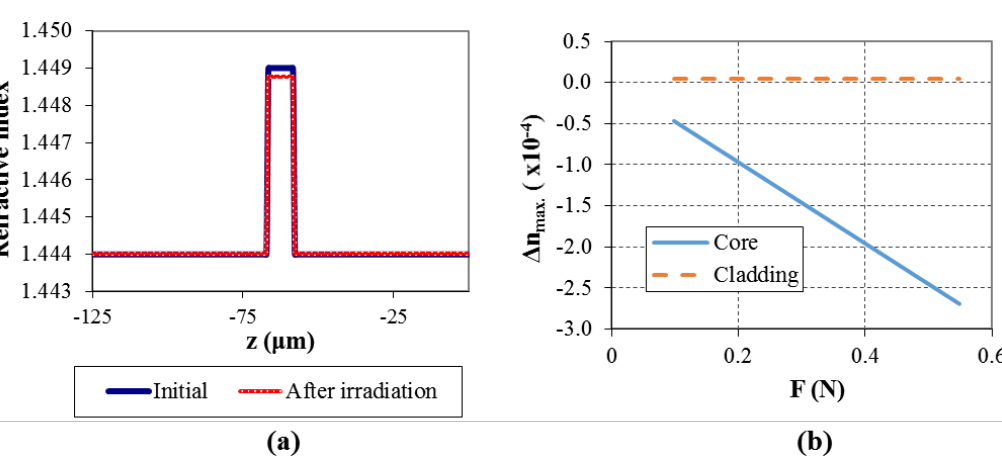
Figure 9. Calculated ( a ) refractive index profiles of the fiber, before and after laser irradiation ( F = 0.461 N); and ( b ) refractive index change (maximum change for core and cladding) for different applied draw tensions. ( P = 6 W; τ = 0.6